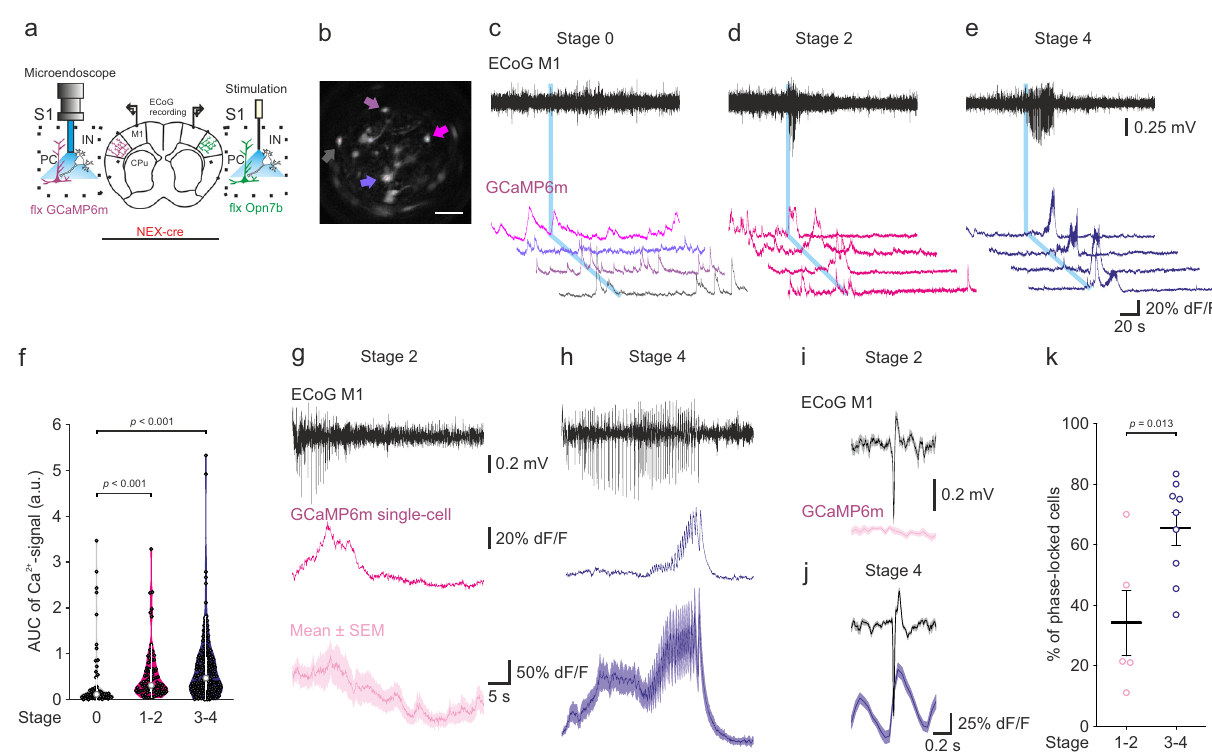
Fig. 5 Calcium dynamics of Opn7b induced epileptiform activity synchronize with electrocorticogram activity. a Schematic example of unilateral injection and stimulation site for fl oxed ( fl x) Opn7b (green), bilateral electrocorticographic (ECoG) recording site and unilateral injection and recording of fl oxed GCaMP (purple) using a microendoscope in primary somatosensory cortex (S1) of NEX-cre mice. Primary motor cortex (M1); Caudate Putamen (CPu); Pyramidal cell (PC); Interneuron (IN). b Representative maximum projection of Ca 2 + signals in S1. Colored arrows represent cells shown in C1 bottom. Scale bar 100 µ m. Recording of epileptiform activity (EA, Top) and unilateral recording of Ca 2 + activity (GCaMP6m, bottom) after blue light (465 nm, 1 s) stimulation revealed varying Ca 2 + activity for stage 0 ( c ), 1-2 ( d ) and 3-4 ( e ) EA. f Area under the curve (AUC) for the Ca 2 + signal following blue light stimulation was signi fi cantly increased for EA of stage 1 – 2 ( n = 86 cells from 5 EAs in 2 animals) and stage 3 – 4 ( n = 180 cells from 9 EAs in 2 animals) in comparison to stage 0 (no EA, n = 62 cells from 2 animals, Kruskal-Wallis-test followed by pairwise Dunn ’ s test, p < 0.001). Small black circles represent individual cells, large gray circle representing median, white box 25th and 75th percentile and whiskers 5th and 95th percentile. g Representative example of stage 2 EA in the ECoG recording (Top, black), the Ca 2 + activity of an individual cell (middle) and mean activity of all recorded cells during the EA (bottom, n = 18 cells) and ( h ) stage 4 mean Ca 2 + activity ( n = 20). g and h solid line represents mean, while shadowed area represents the ±SEM. i Example of peak triggered average for EA (top, ECoG M1) and its corresponding average Ca 2 + signal (bottom, GCaMP6m) showed low phase locking of the Ca 2 + signal with the EA for stage 2 ( n = 13 peaks, same EA as depicted in g). j but high phase-locking for stage 4 EA ( n = 50 peaks, same EA as depicted in h). Solid line represents mean, while shadowed area represents the ±SEM. k The percentage of phase-locked cells during EA is signi fi cantly higher during stage 3 – 4 EA ( n = 9 EAs from 2 animals) than during stage 1 – 2 EA ( n = 5 EAs from 2 animals, t (12) = − 2.903 two-sided independent samples t test). Each circle represents individual EA, while the bar represents the mean value for all. Error bars represented as ±SEM. Source data